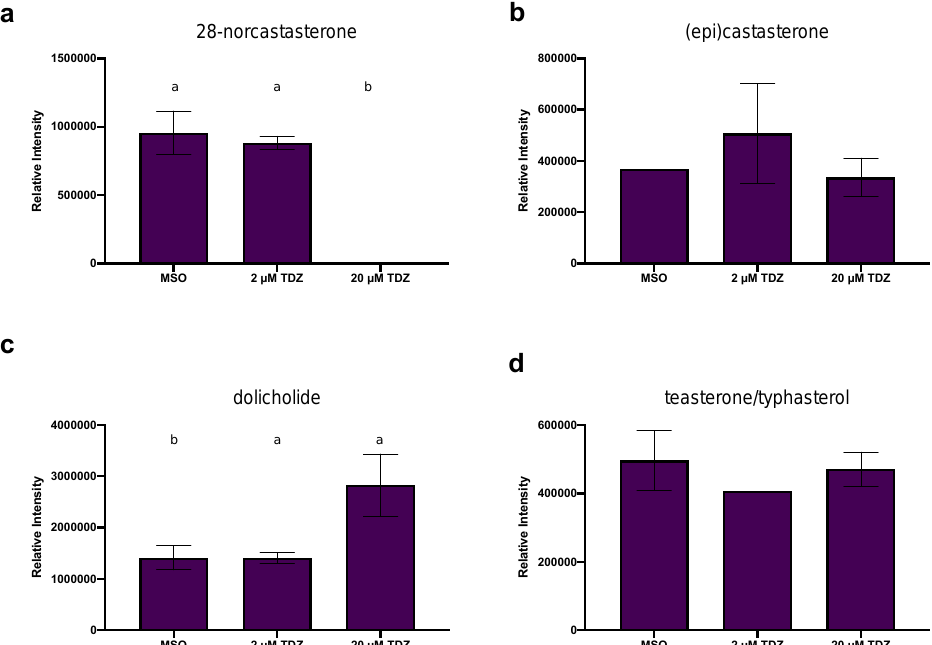
Figure 4. E ff ects of thidiazuron (TDZ) exposure on brassinosteroids ( a ) 28-norcastasterone, ( b ) epicastasterone or castasterone, ( c ) dolicholide and ( d ) teasterone or typhasterol levels in African violet petioles. Bars represent mean, error bars span standard error margin. Where no error bars are displayed, the feature was present in only one replicate. Biomolecules 2020 , 10 , x